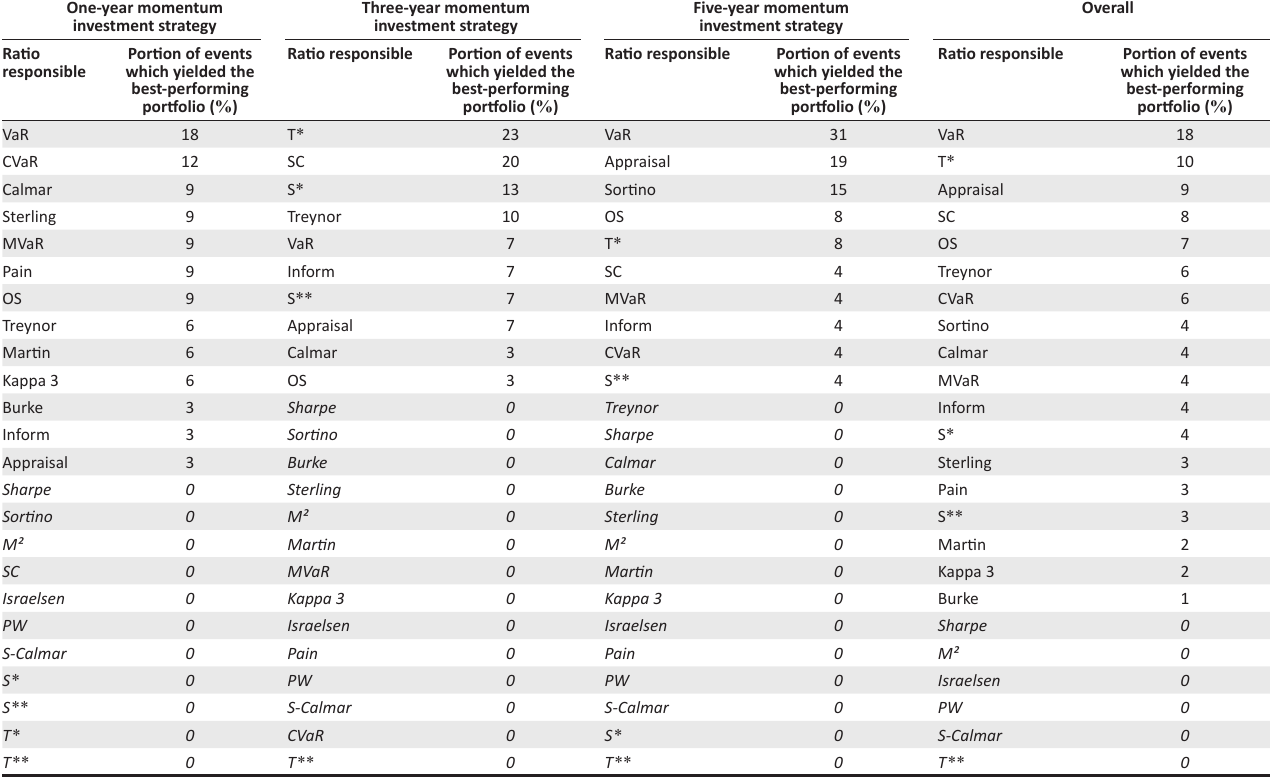
TABLE 8: Overall summary of credibility of ratios. One-year momentum investment